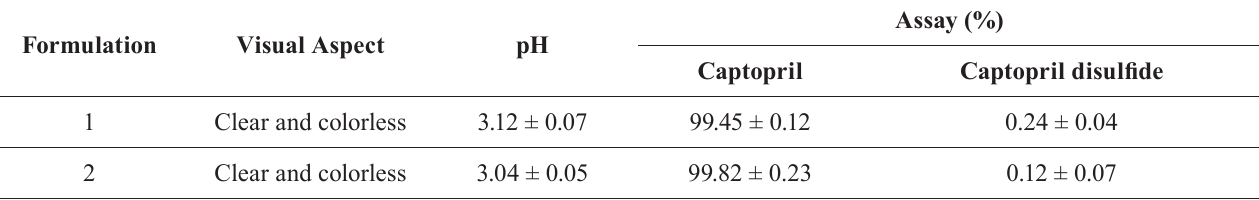
TABLE V - C haracterization of formulations containing captopril and captopril disulfide